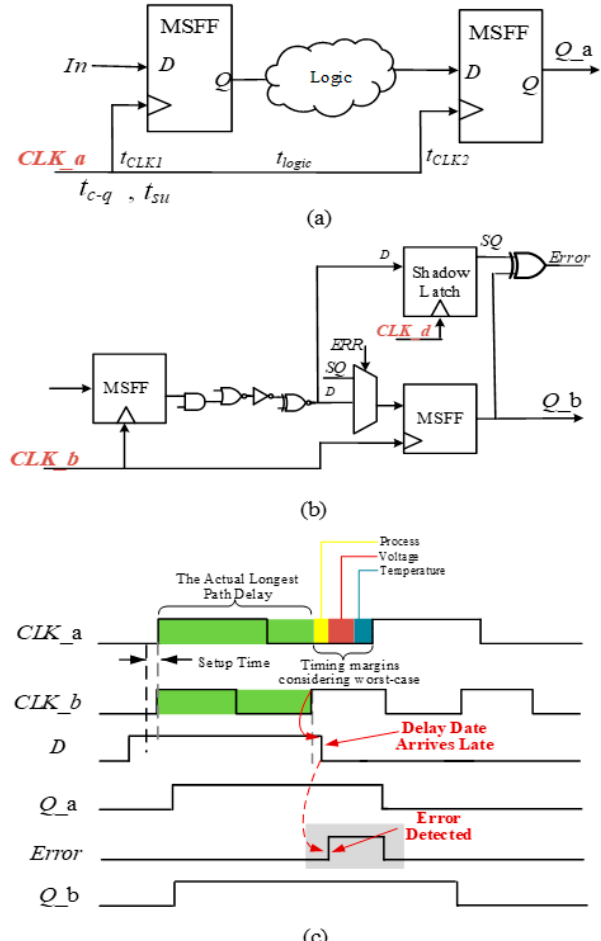
Figure 2. ( a ) Conventional circuit design. ( b ) Timing error-tolerant design RFF [13]. ( c ) The timing diagram of main signals with nominal and late arriving inputs. diagram of main signals with nominal and late arriving